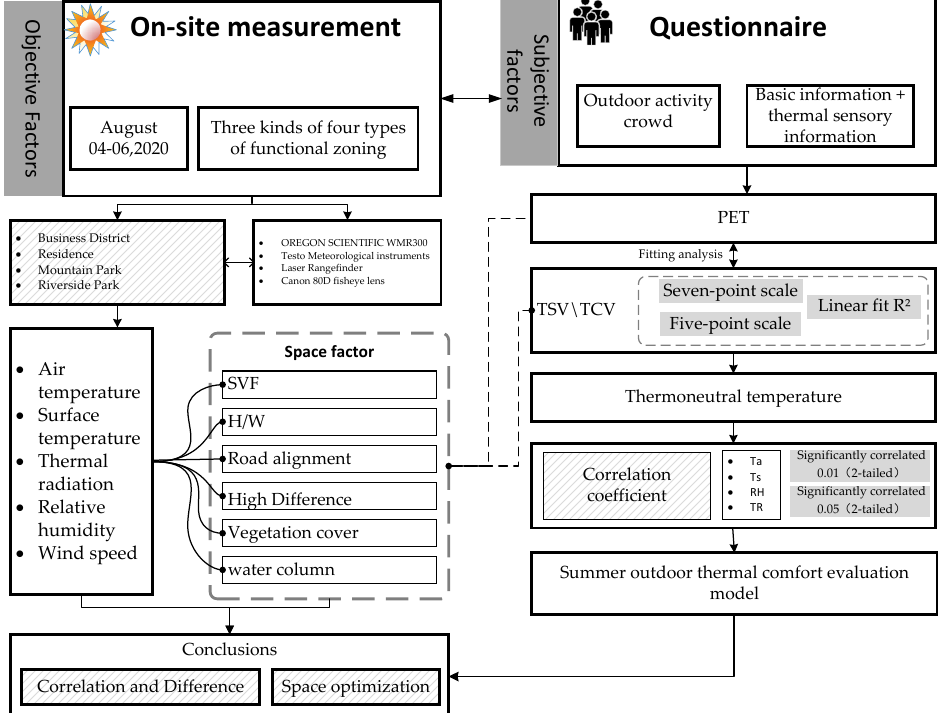
Figure 1. The methodological framework of the